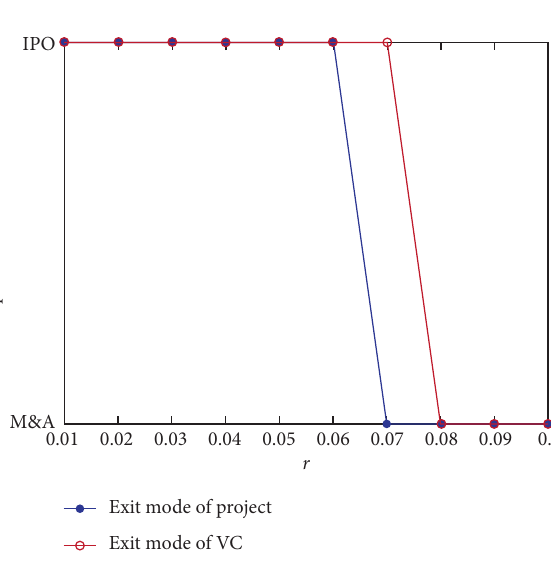
Figure 11: Optimal exit decision ( k � 5 )